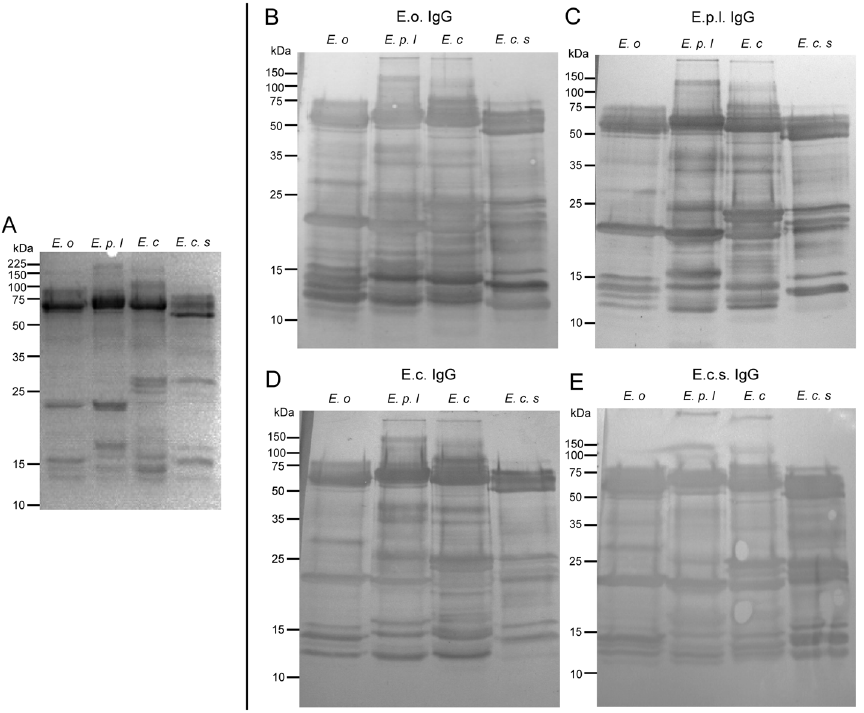
Figure 2. Echis species-specific IgG antisera exhibit extensive cross-specific venom protein reactivity. The venom proteins of E. ocellatus (E.o) , E. p. leakeyi (E.p.l) , E. coloratus (E.c) and E. c. sochureki (E.c.s) visualised using reduced SDS-PAGE (A), after immunoblotting, showed extensive cross-specific reactivity with IgG antisera specific to E. ocellatus (B), E. p. leakeyi (C), E. coloratus (D) E. c. sochureki (E). The sera were diluted 1:5,000 and 7 m g of each venom was used in all